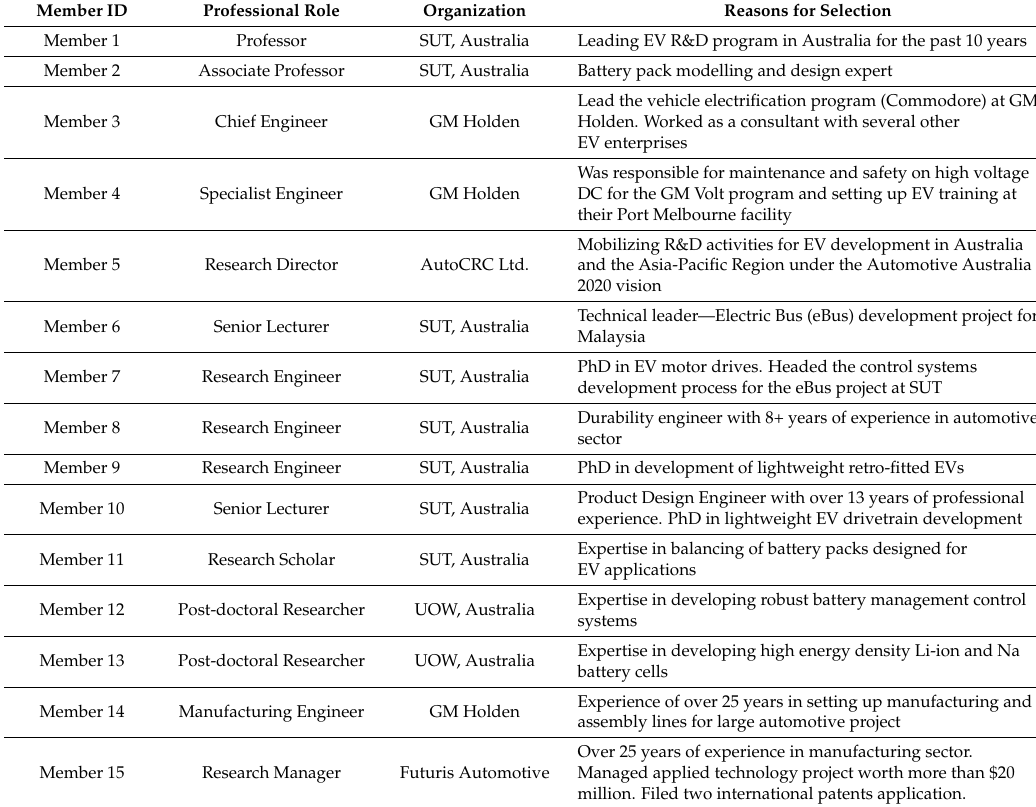
Table 2. Details of the expert panel formed to identify implicit customer requirements for EV battery pack where, SUT refers to Swinburne University of Technology; UOW is University of Wollongong and GM stands for General